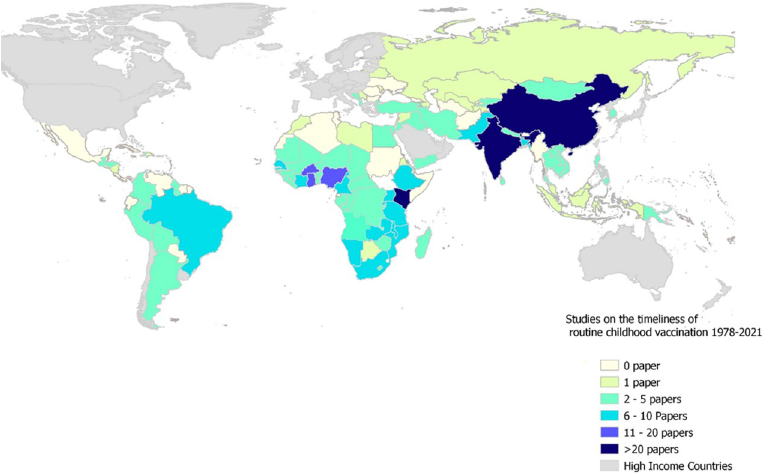
Fig 3. Map of the world showing low-and middle-income countries where studies on the timeliness of routine childhood vaccination has been conducted, 1978–2021. This map was produced by the authors with administrative boundaries data from geoBoundaries